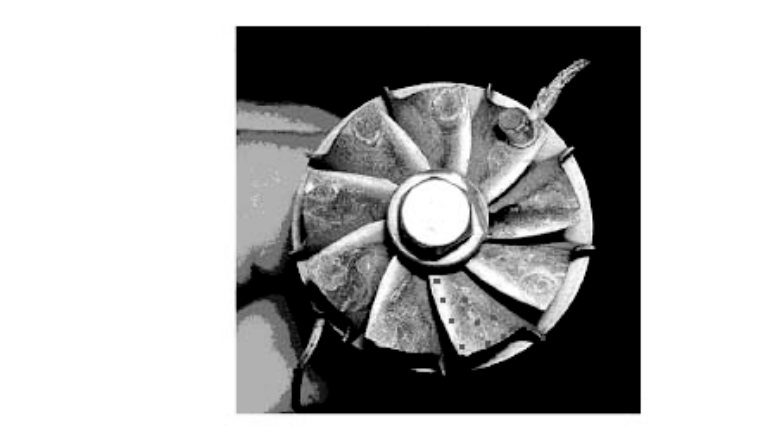
Fig. 14. Blade’s measure points.